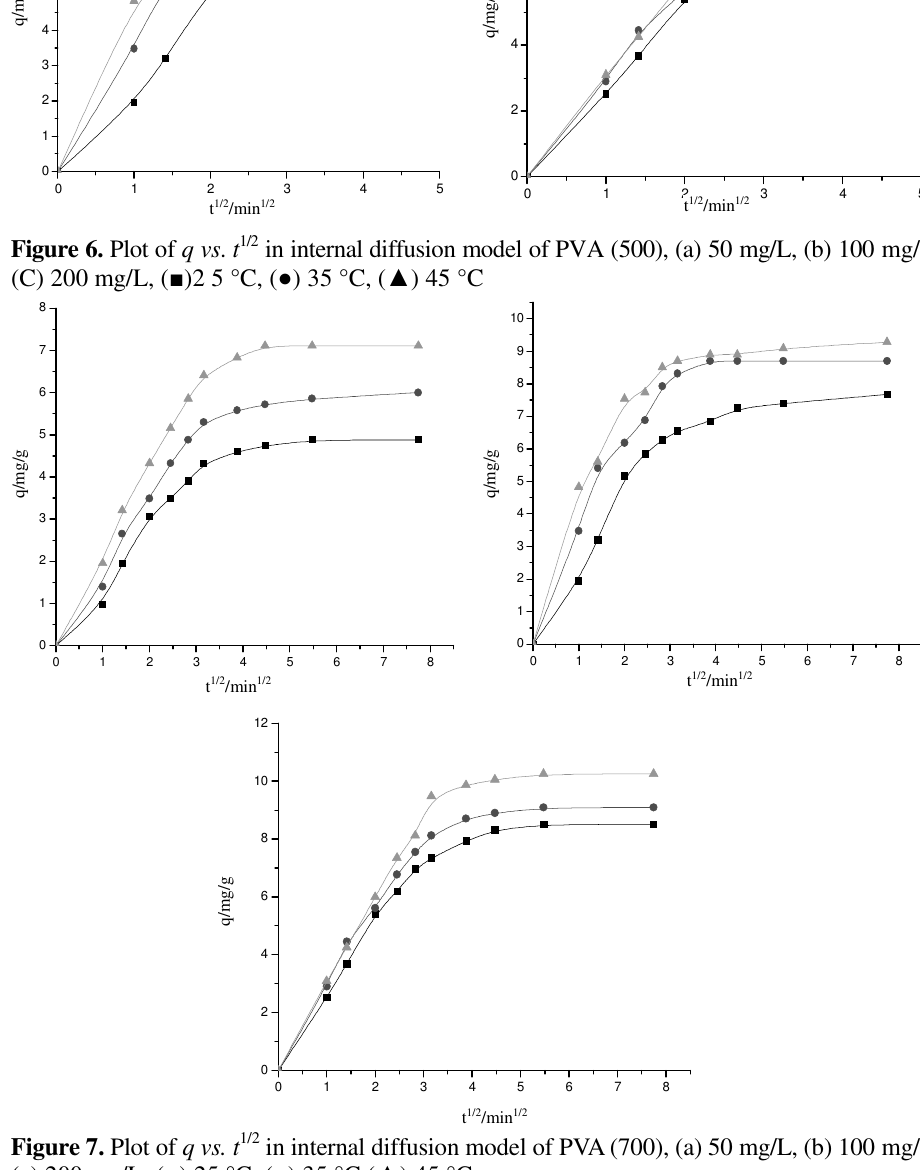
Figure 7. Plot of q vs. t 1/2 in internal diffusion model of PVA (700), (a) 50 mg/L, (b) 100 mg/L, (c) 200 mg/L; ( ■ ) 25 °C, ( ● ) 35 °C,( ▲ ) 45